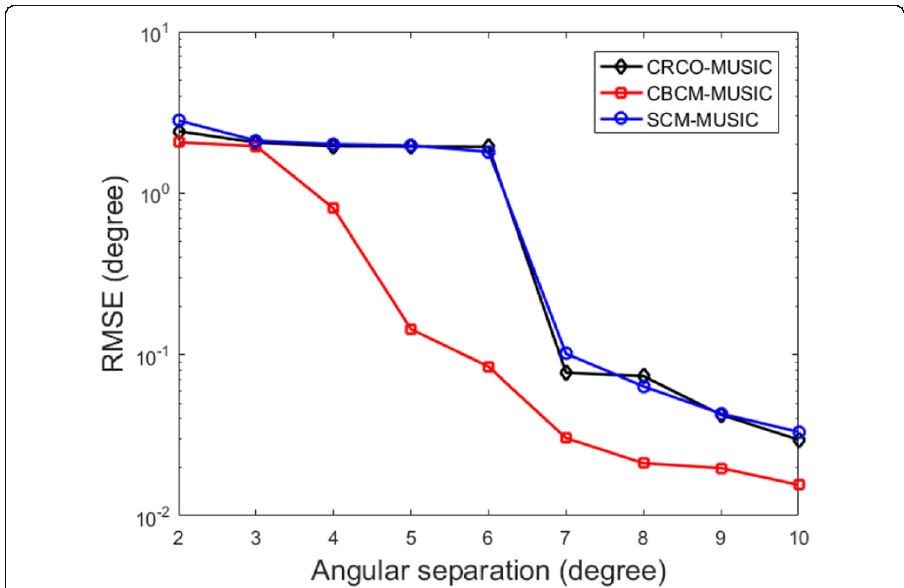
Fig. 19 RMSE against the angular separation